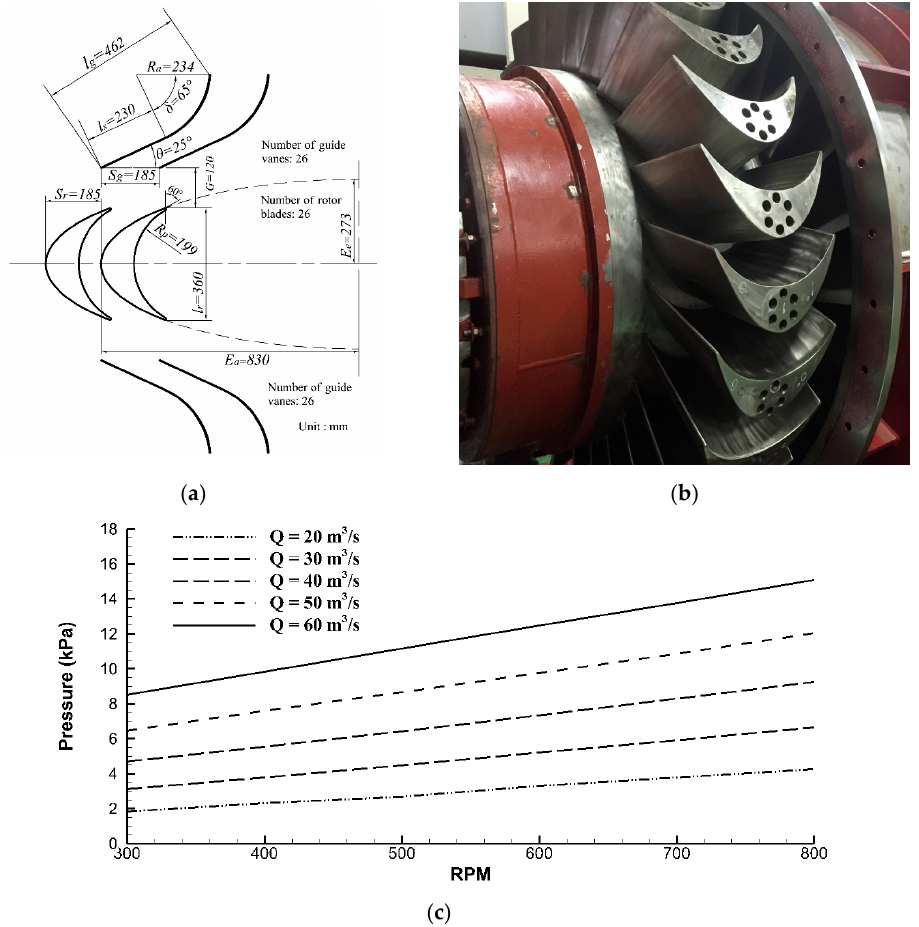
Figure 5. Definition of 250 kW impulse turbine in Yongsoo OWC and performance chart. ( a ) Sketch of design; ( b ) Snapshot of installed turbine; ( c ) Performance chart. of design; ( b ) Snapshot of installed turbine; ( c ) Performance